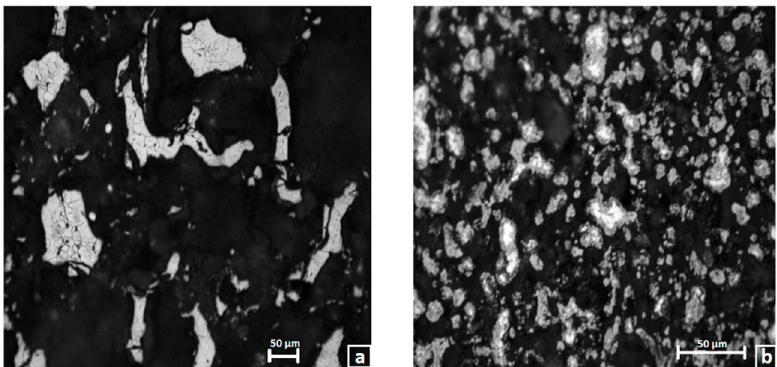
Figure 14. Microstructure of chromium that has been burned in the forced ( a ) and natural ( b ) filtration modes.